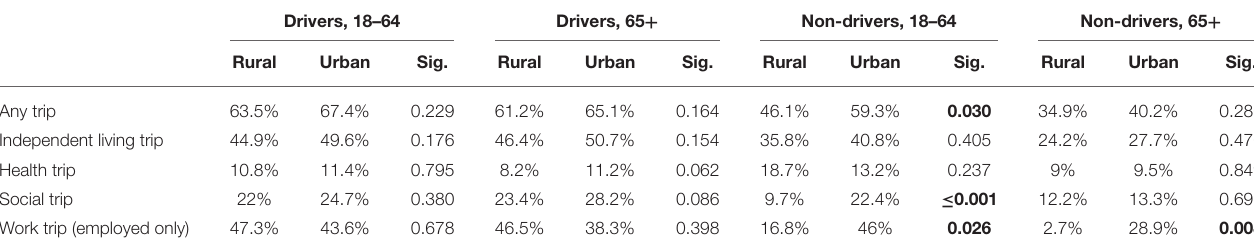
TABLE 2 | Trips taken by drivers and non-drivers with disabilities, by rural/urban (weighted). Drivers, 18–64